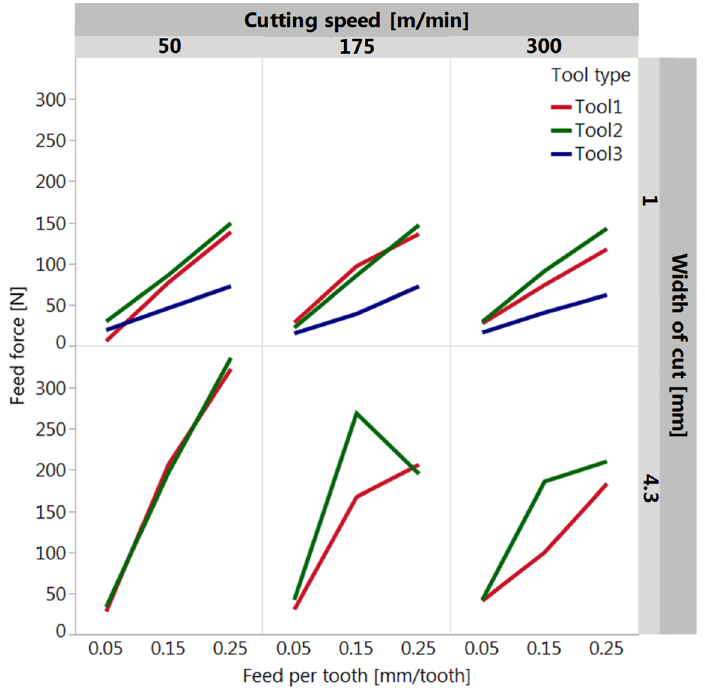
Figure 18. Feed force according to the interaction between ft , v and ae for each cutter.